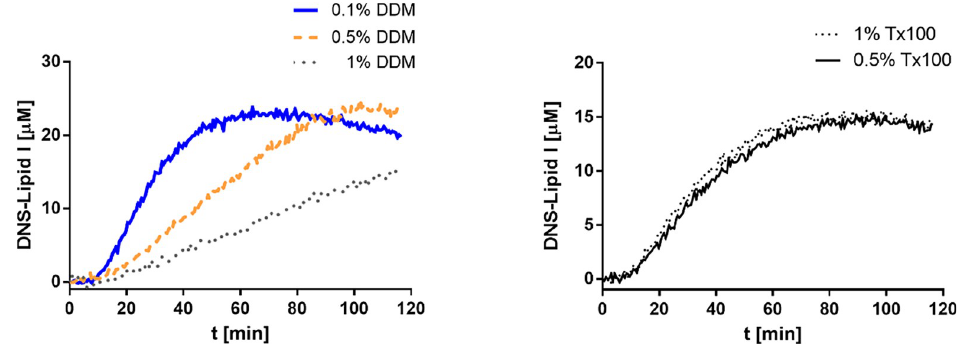
Fig 8. The influence of detergent on SMA-MraY activity. (A) DDM concentrations from 0.1% to 1% were used in DNS-Lipid I synthesis. The reaction was followed for up to two hours and it reached equilibrium faster when 0.1% DDM was used. (B) Triton X-100 at two different concentrations (0.5% and 1%) did not affect reaction rate as the time when the equilibrium was reached under these conditions was almost undistinguishable.